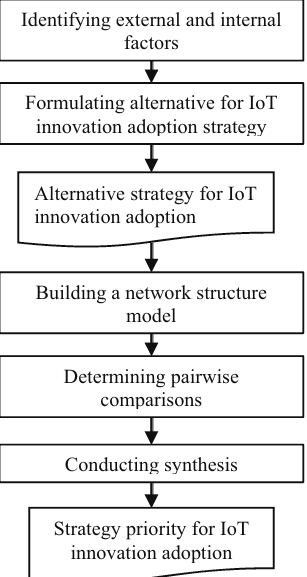
Figure 1: Research